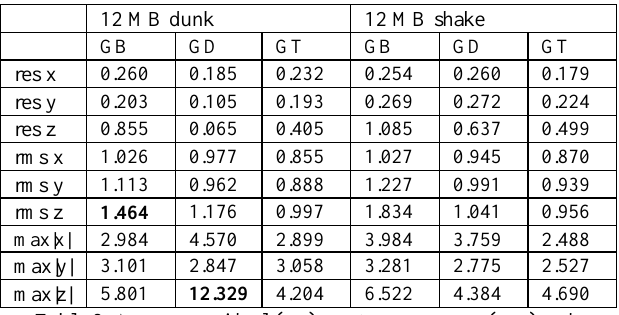
Table 8: Average residual (res), root mean square (rms) and Table 9: Average residual (res), root mean square (rms) and maximal absolute residual value (max|v|) of all check points in maximal absolute residual value (max|v|) of all check points in mm (12MB dunk and shake) after removing the sequences mm (7MB dunk) after removing the sequences containing errors containing errors. and after removing the systematic trend. Similar good are the results for the 12MB dunk and 12MB shake series. The maximum rms value is 0.653 mm and the largest maximum residual is 3.781mm again in the z